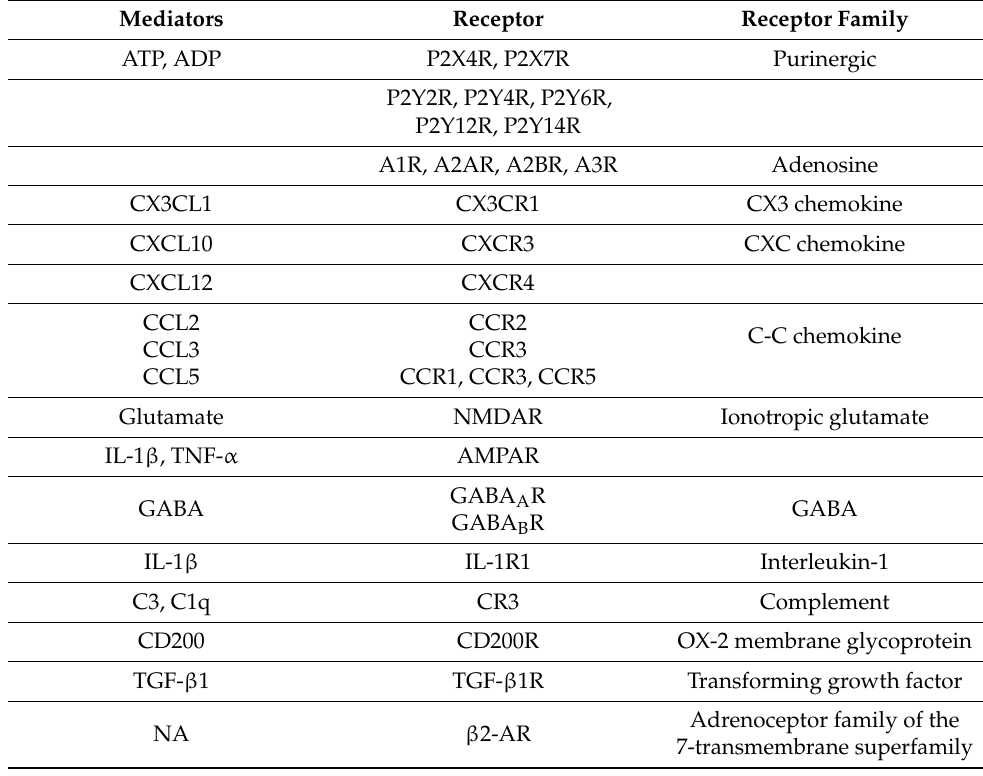
Table 2. Common microglial mediators and their receptors involved in synaptic